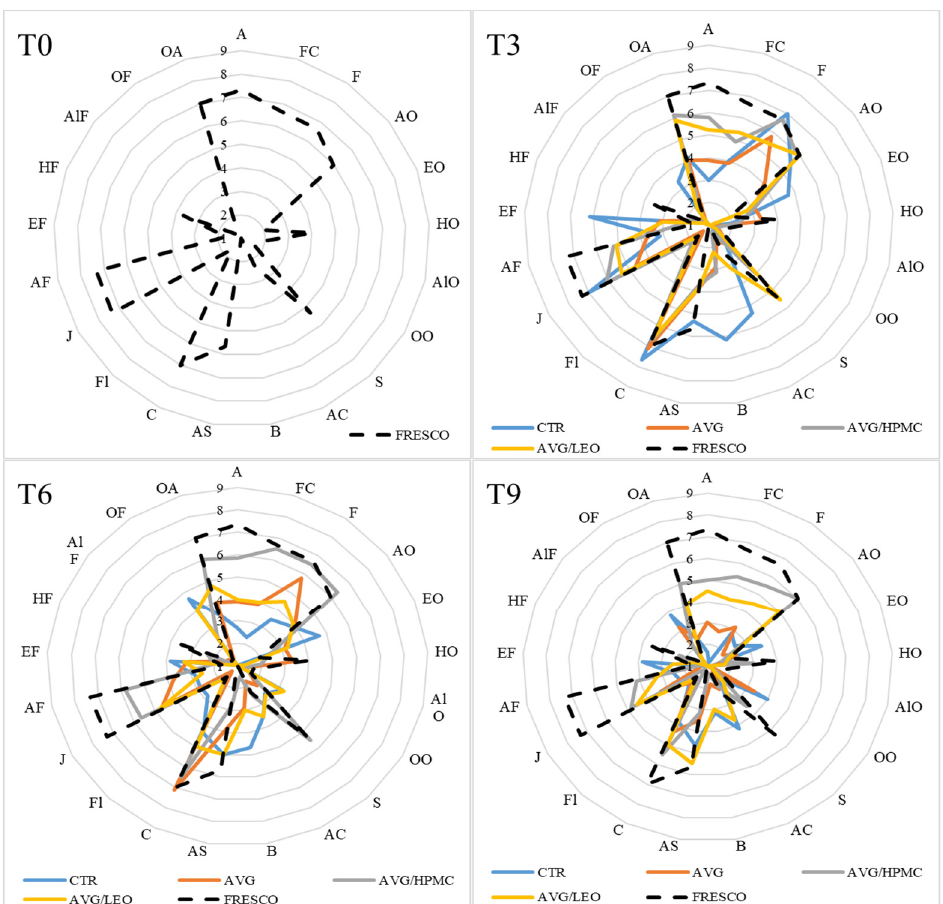
Figure 2. Sensory analyses of treated and untreated fresh − cut apples at 0, 3, 6, and 9 days of storage at 4° ± 1 °C and 90% ± 5% RH. Descriptors legend: appearance (A), flesh color (FC), firmness (F), apple odor (AO), herbaceous odor (EO), honey odor (HO), almond odor (AlO), off − odor (OO), sweetness (S), acidity (AC), bitter (B), astringent (AS), crunchiness (C), flouriness (Fl), juiciness